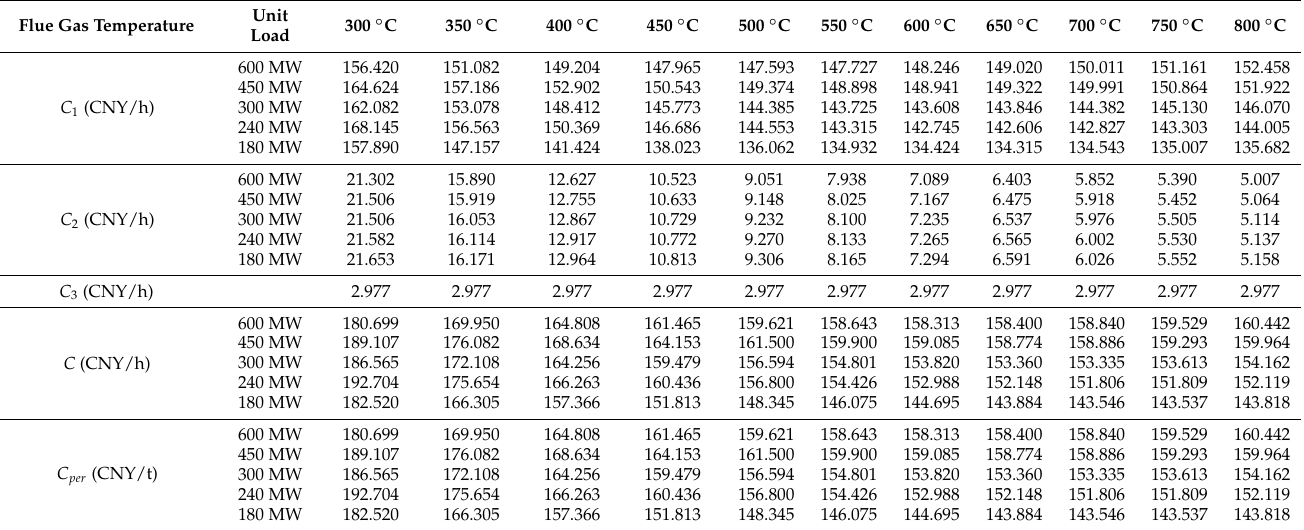
Table 4. Economic parameters under different unit load operating